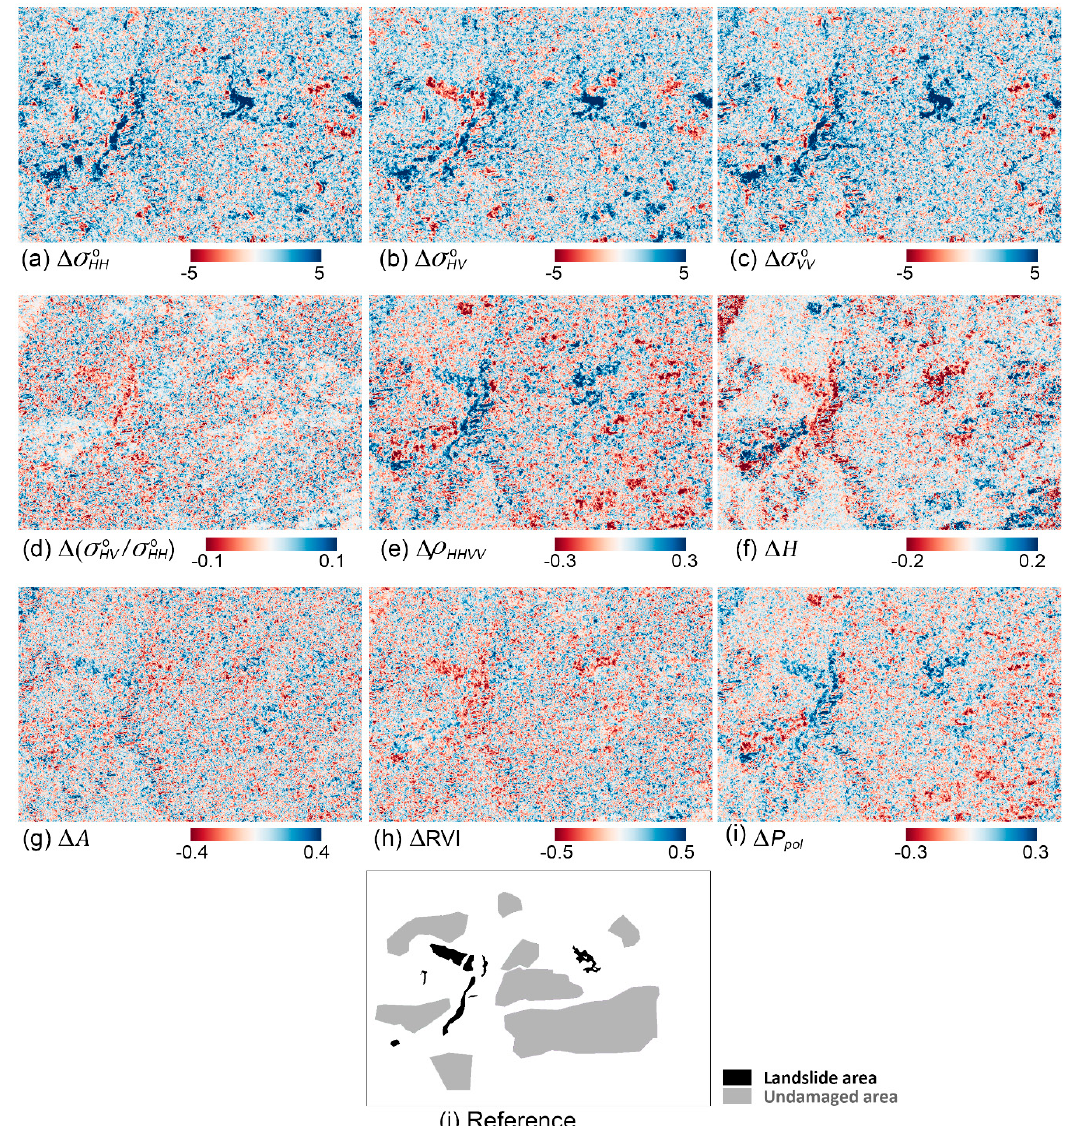
Figure 7. Difference images of different polarimetric parameters ( a - i ) and manually determined Figure 7. Di ff erence images of di ff erent polarimetric parameters ( a – i ) and manually determined regions regions of interests ( j ) of landslide and undamaged areas. of interests ( j ) of landslide and undamaged